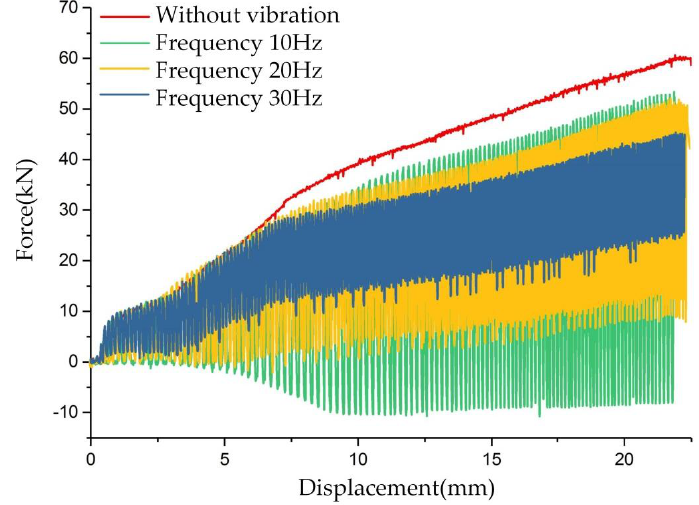
Figure 7. Comparison of load–displacement curves of clutch hub forming with different vibration frequencies.